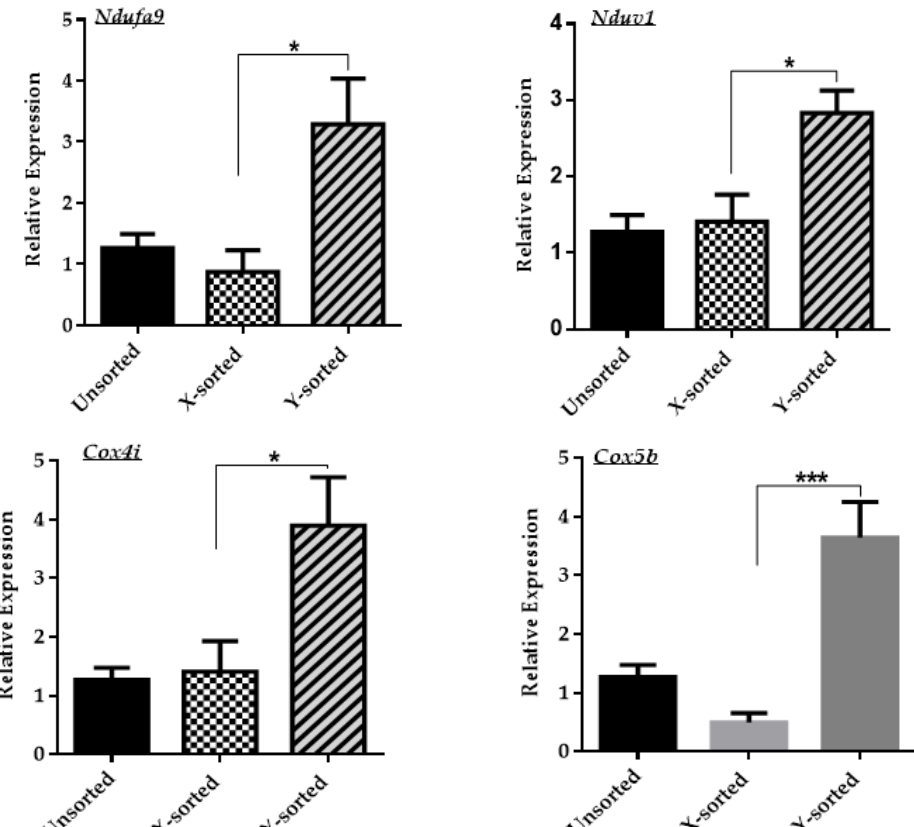
Figure 3. Differences in the mitochondrial OXPHOS system attributed to the development of X- and Y-BLs. Relative mRNA expression analysis of mitochondrial OXPHOS subunit genes, Ndufa9, Ndufv1, Cox4i, Cox5b in unsorted, X-, and Y-sperm-sorted BLs at day seven. Data in the bar graphs represent the means ± SEM from three independent sets of experiments. * p < 0.05; *** p < 0.001.